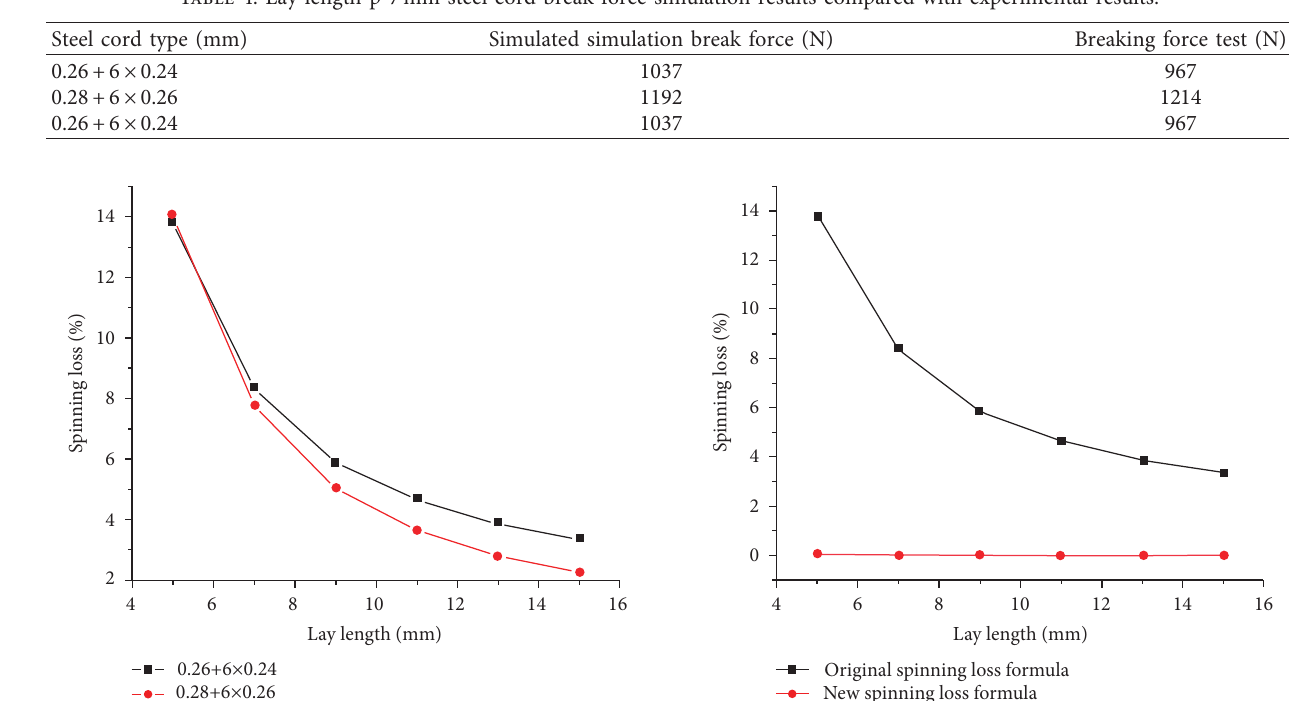
Table 4: Lay length p-7mm steel cord break force simulation results compared with experimental results.